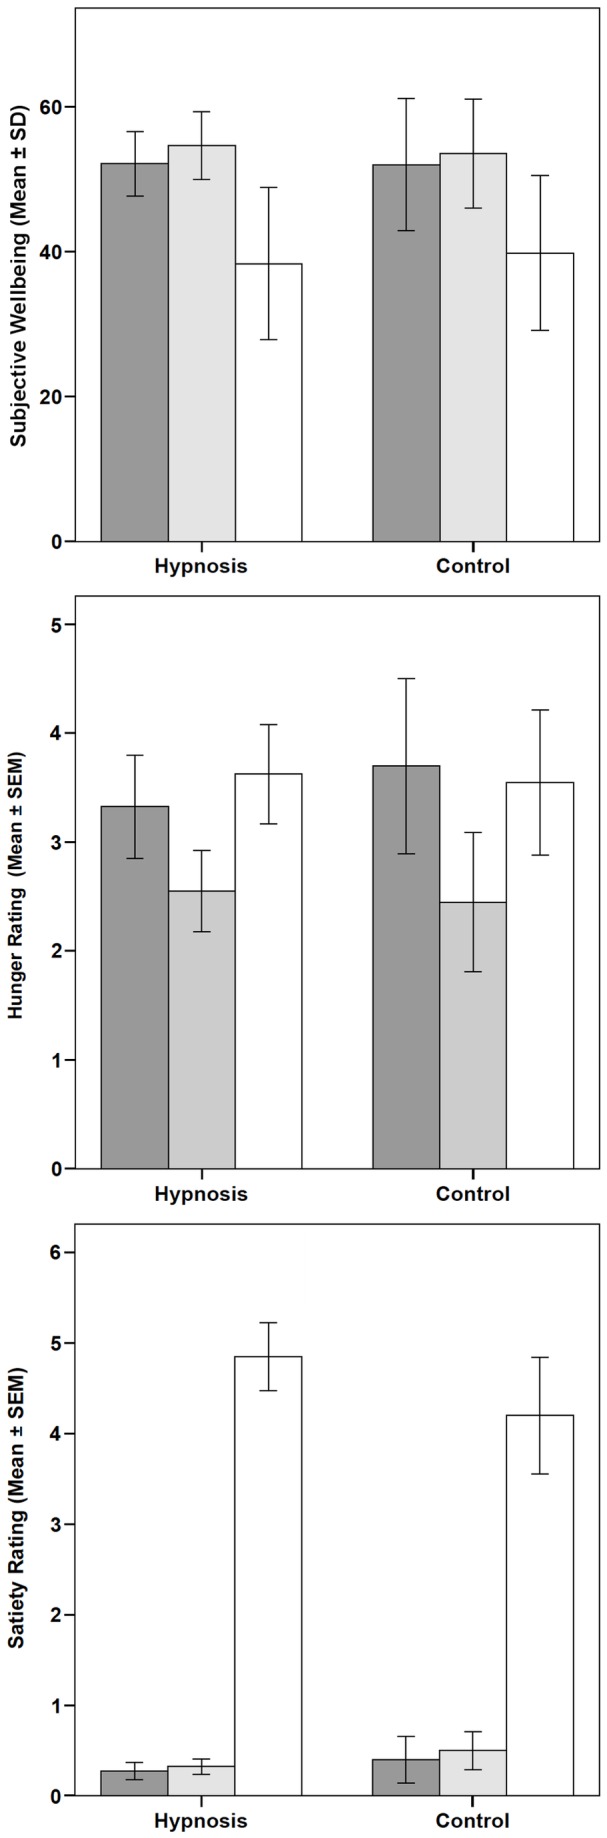
Subjective well-being scores (computed from 7 items rated on a visual analog scale) (A), and hunger (B) and satiety (C) ratings at three different time points (baseline and after both meal imaginations).Each block of columns represents data from hypnosis (left) and relaxation/concentration (right).